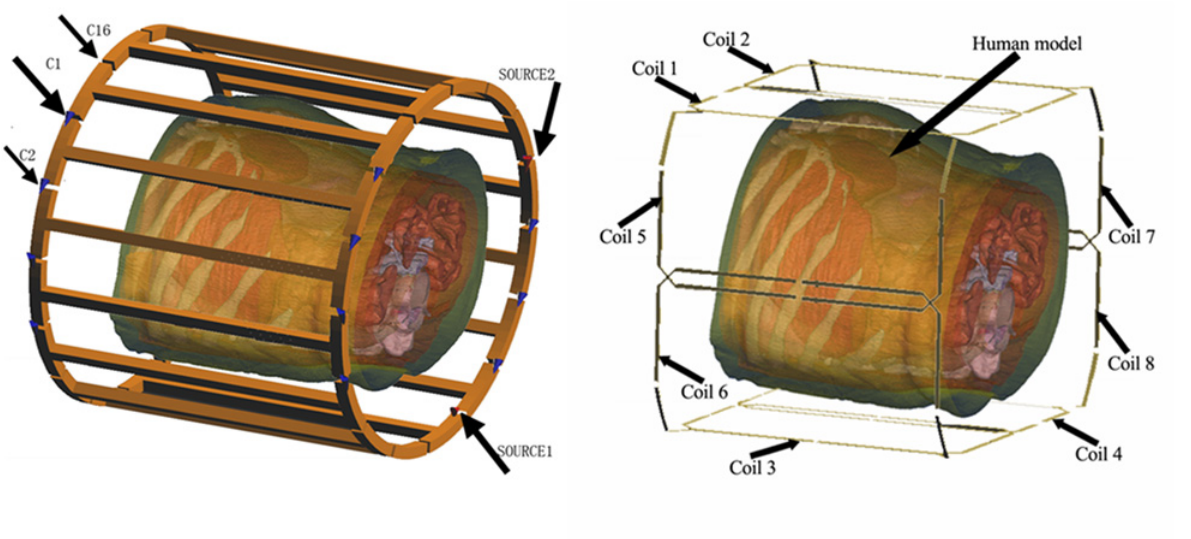
Fig 3. The 16-leg high pass body coil and the eight-element receive phased array coil loaded with human 3D liver electromagnetic model including fourteen different tissues.